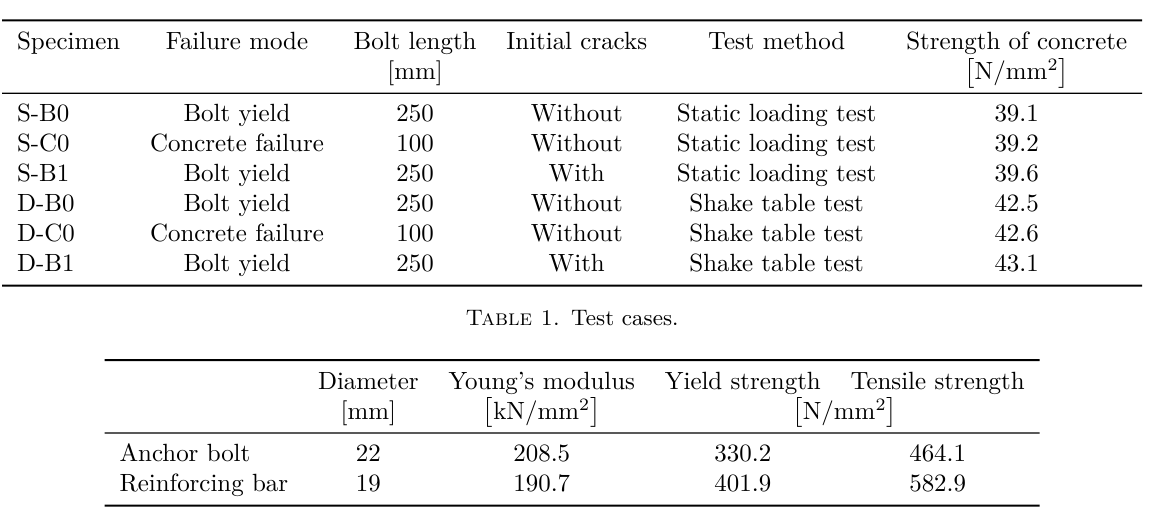
Figure 1. Test specimens (Unit: mm).